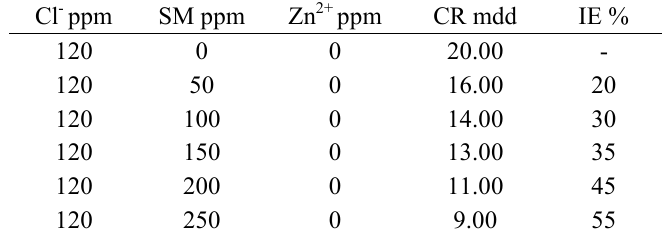
Table 1. Corrosion rates(CR) of Carbon steel in aqueous solution in the presence of inhibitor and the inhibition efficiency obtained by weight loss method. Inhibitor System: SM+Zn 2+ pH=7, Immersion Period: one